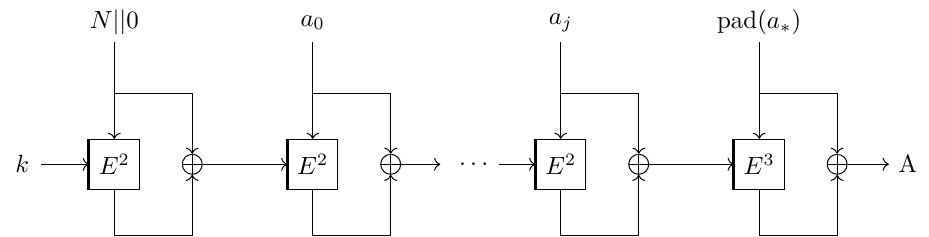
Figure 7: Cascade construction, processing of the associated data. A thick line represents the input of the key.